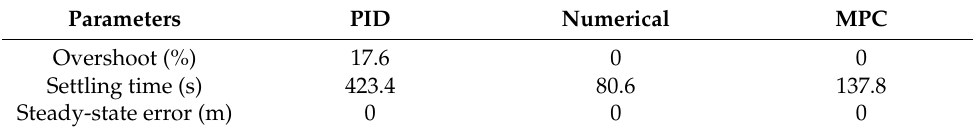
Table 1. Comparison of PID, numeric, and MPC controllers in terms of the level variable.